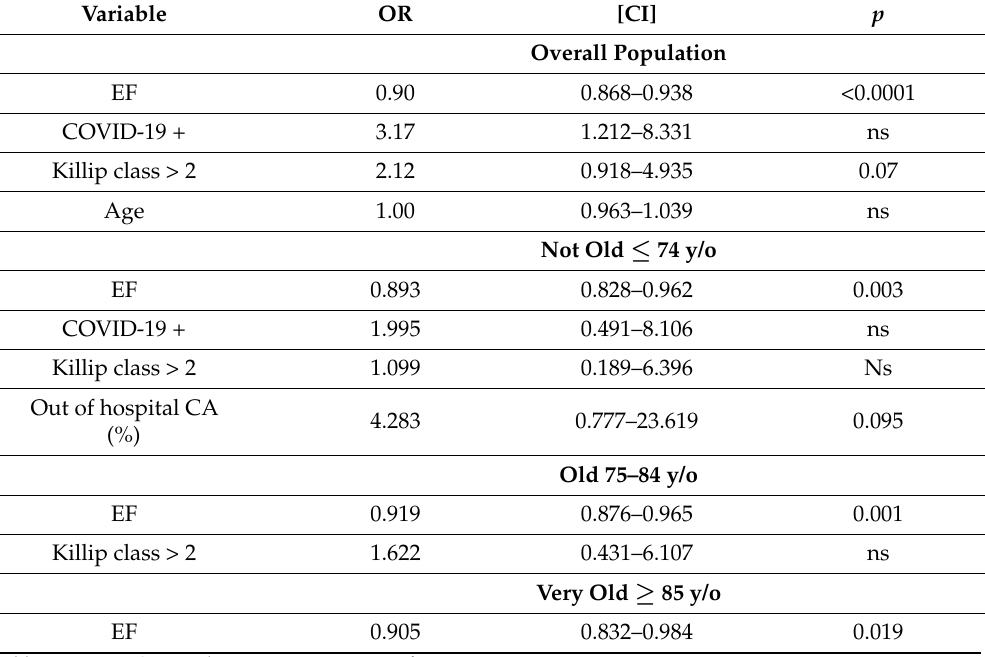
Table 3. Multivariate analysis of in-hospital